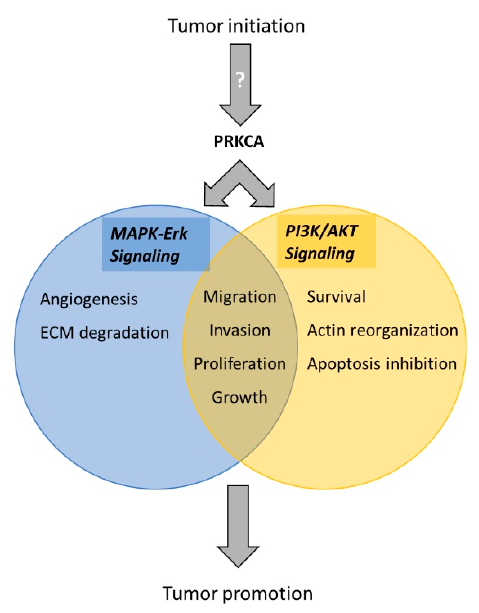
Figure 4. Model of the role of PRKCA in tumorigenesis and progression. Activation of PRKCA is known to elicit downstream tumor-promoting effects via the MAPK/Erk and PI3K/Akt signaling pathways in several cancer types [40–44]. Both pathways are known to promote cell growth, proliferation, migration and invasion. Additionally, MAPK/Erk also promotes angiogenesis and degradation of the extracellular matrix (ECM), while dysregulation of the PI3K/Akt pathway can lead to actin reorganization, improved cellular survival, and inhibition of apoptosis [38,39]. The tumor-initiating mechanism of PRKCA activation and overexpression is unknown.